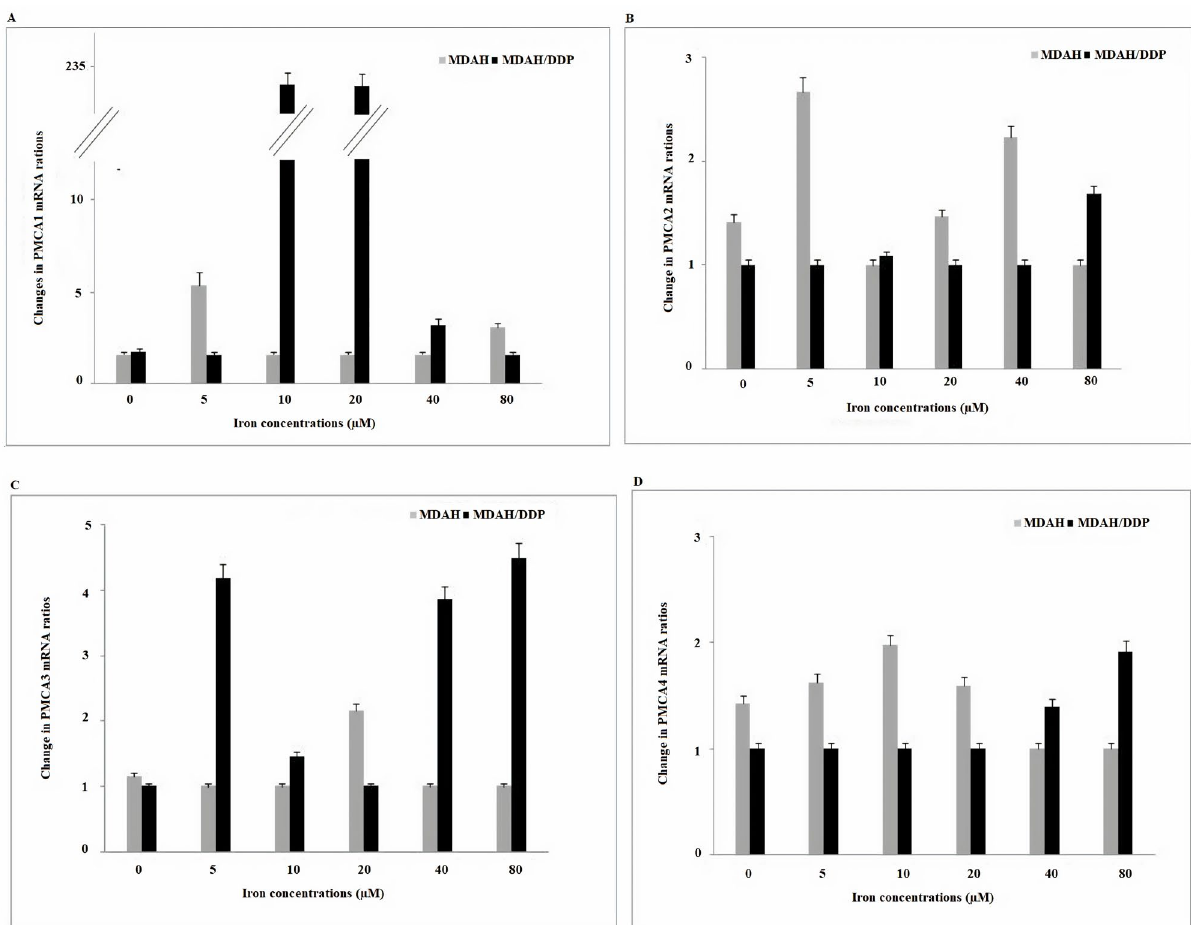
Figure 5. Gene expression of PMCA1/2/3 and PMCA4 channels in the plasma membrane at increasing iron concentrations in MDAH and MDAH/DDP cells. The levels of change in mRNA gene expression rates for each sample were determined with respect to P-actin by RT-PCR method. A: PMCA1 ; B: PMCA2 ; C: PMCA3 ; D: